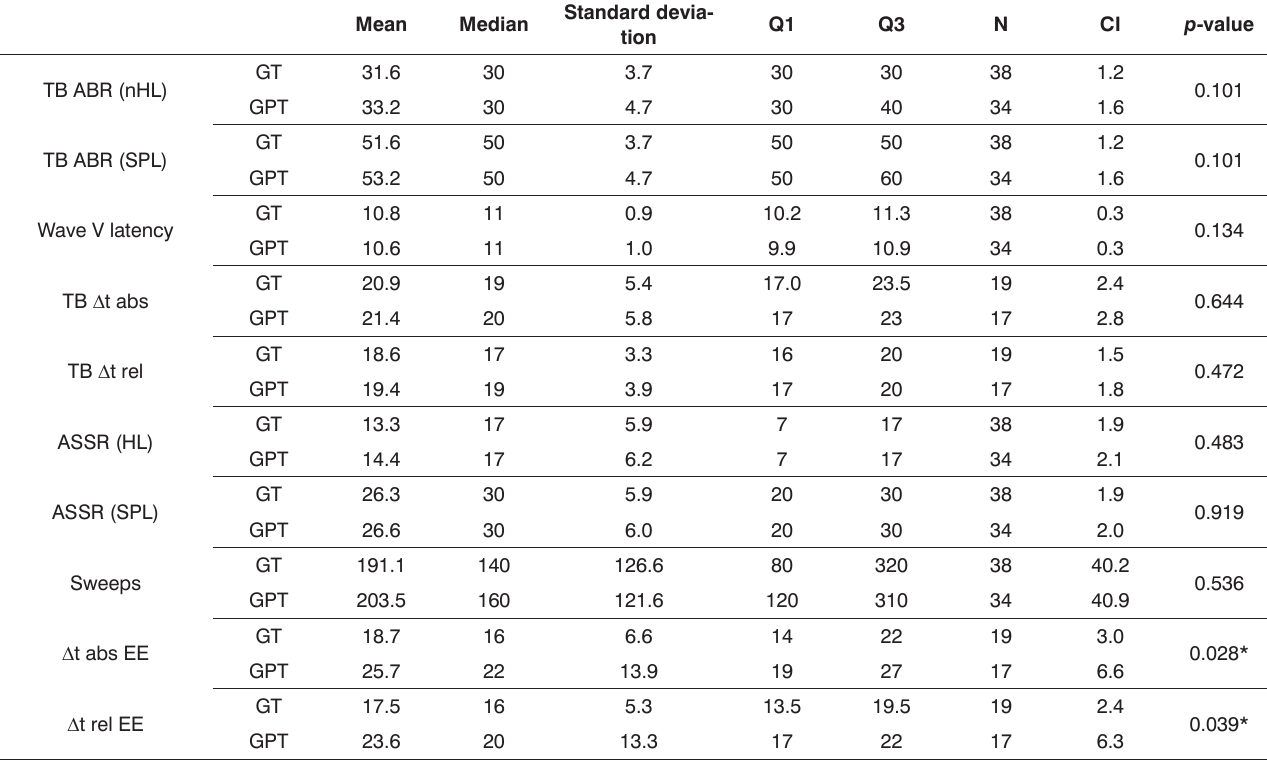
Table 2. Comparison of results among term and preterm subjects relative to the minimum tone burst ABR and ASSR responses (in dBnHL and dBSPL), V wave latency in ms (tone burst ABR), absolute and relative times (tone burst ABR and ASSR), minimum ASSR (in dBHL and dBSPL), and the number of sweeps to measure the minimum